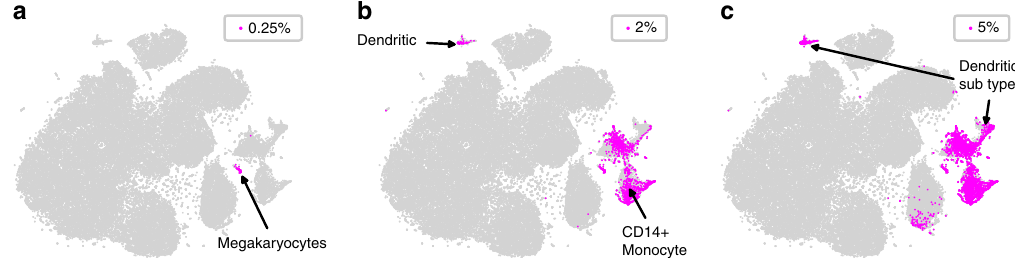
Fig. 2 FiRE discovers cells with varying degrees of rareness. In the ~68 k PBMC data 3 , minor cell populations with different grades of rarity show up with an increase in the number of selected rare cells. a – c The top 0.25, 2 and 5% cells, respectively, selected on the basis of FiRE scores are